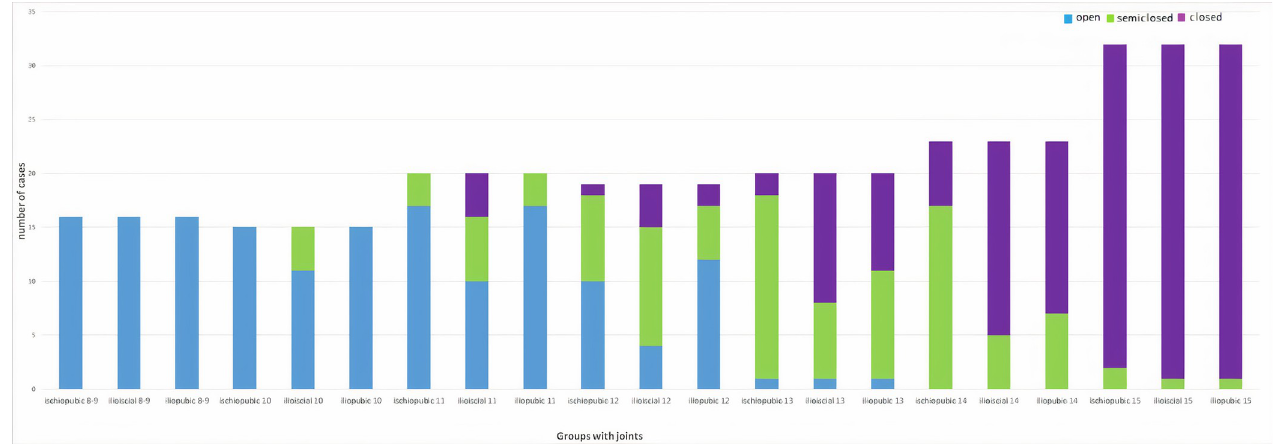
Fig 8. In boys, there is frequency distributions by groups for ischiopubic, ilioischial, and iliopubic synchondrosis. 0: Blue (open), 1: Green (semiclosed), and 2: Purple (closed).